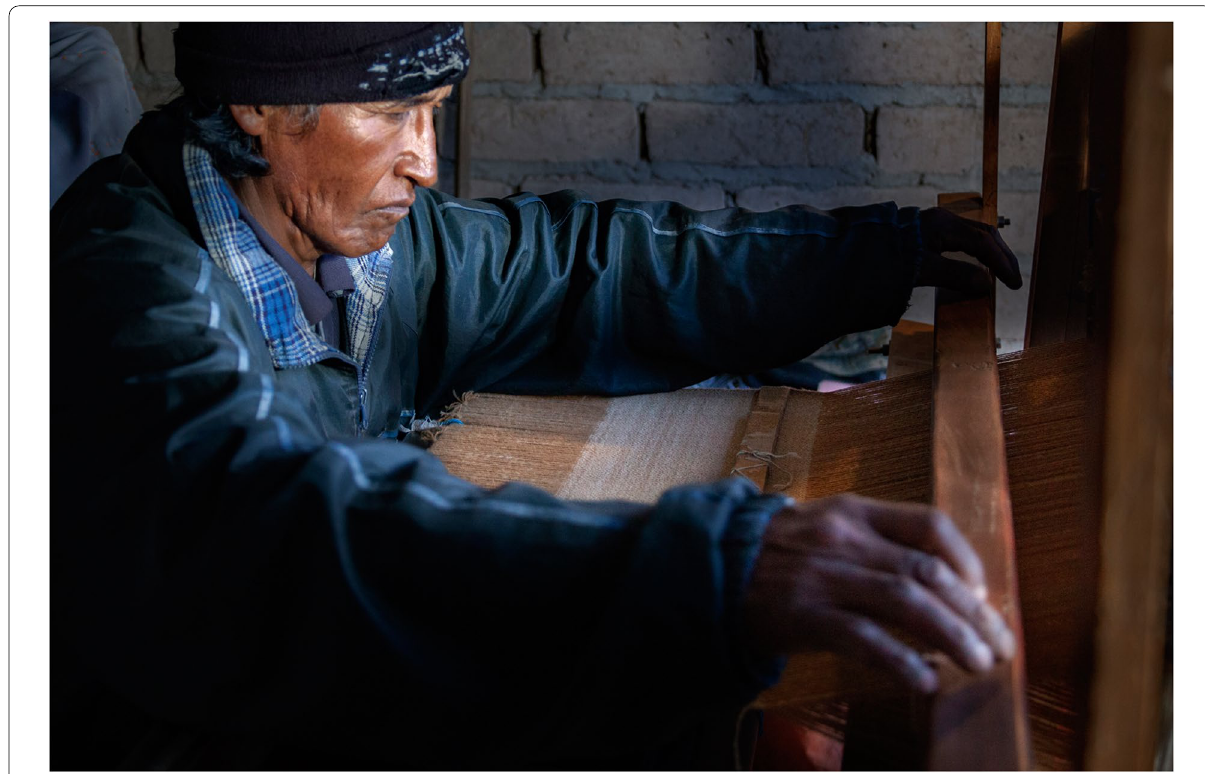
Fig. 2 Eusebio weaving in the loom. Photo by Silvina